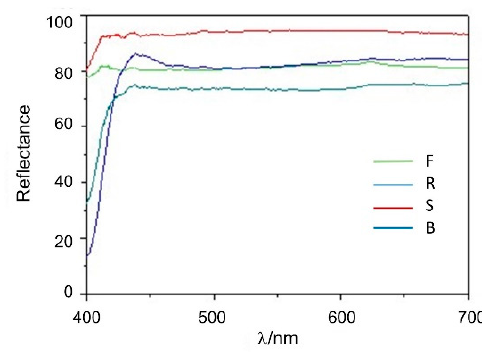
Figure 1. Reflectance curves of papers; F-filter paper, S-synthetic paper, B-bulky paper, R-recycled paper.